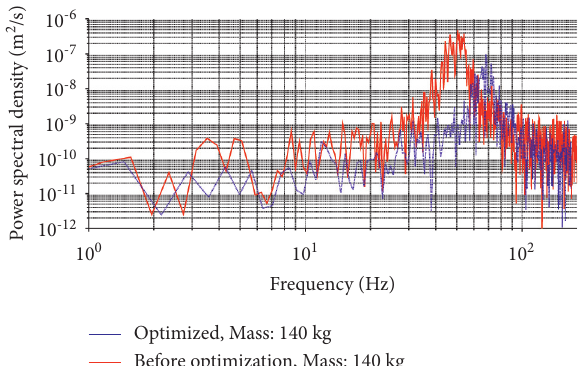
Figure 24: PSD of dynamic tire deflection with frequency before and after the